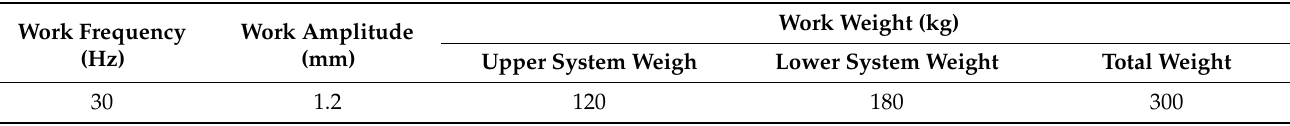
Table 5. VVTE vibration parameter